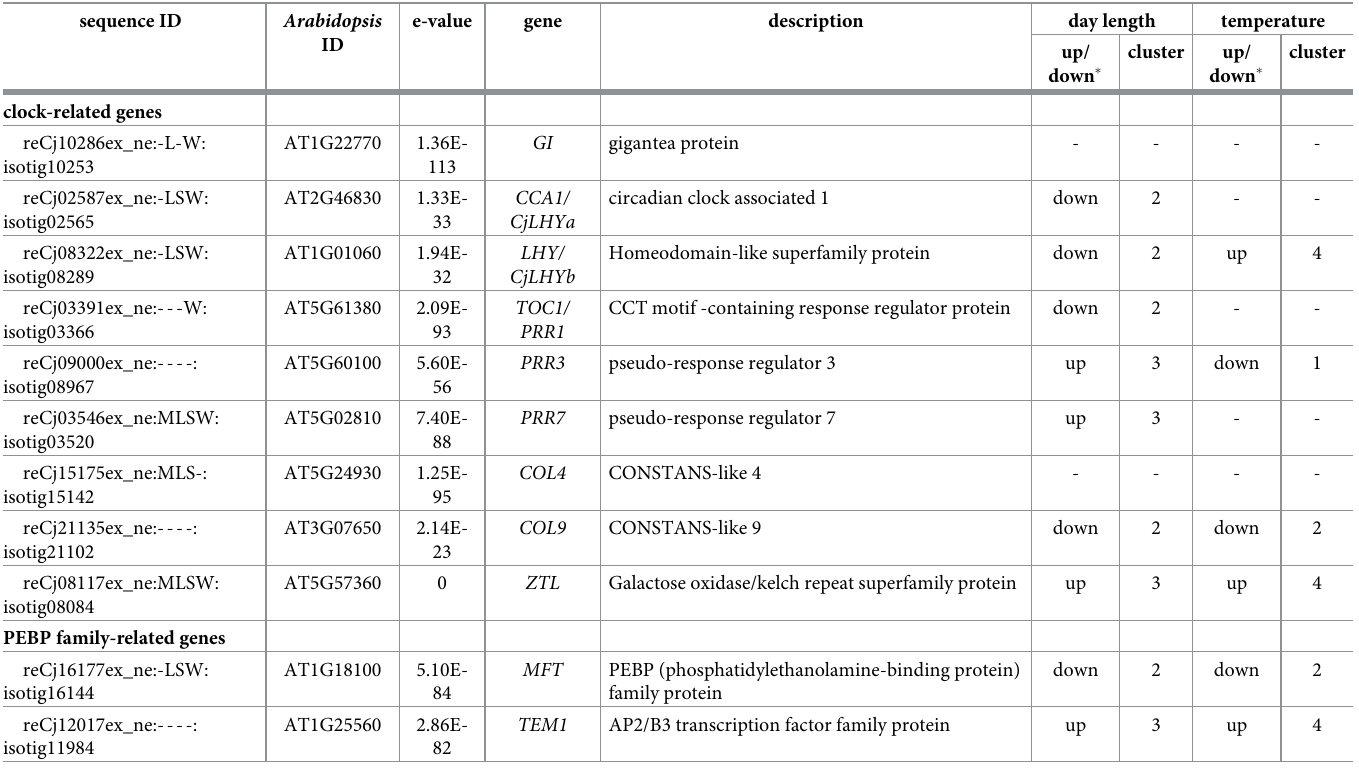
Table 6. Effects of day length and temperature on clock- and PEBP family-related genes. sequence